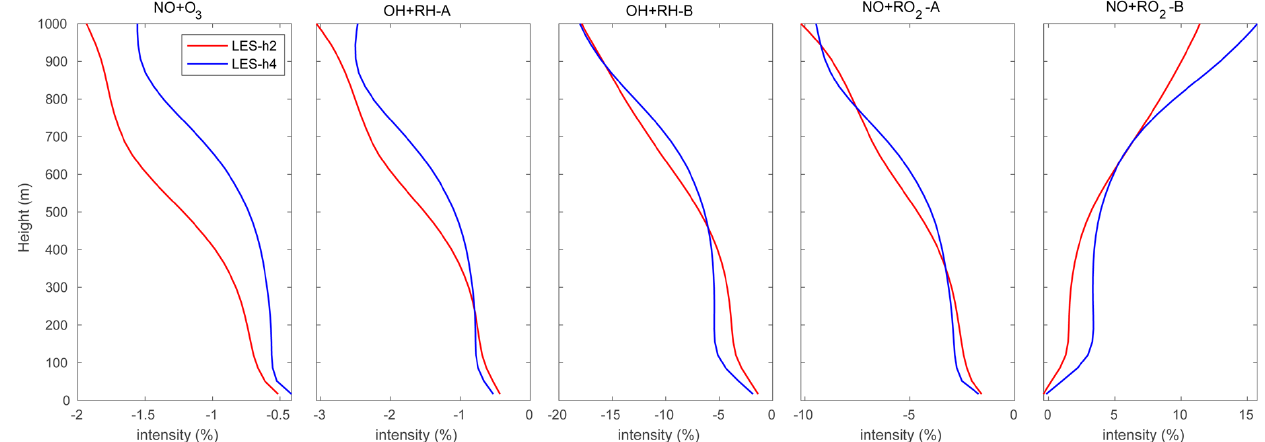
Figure 4. Domain-averaged segregation intensity profiles of selected reactions at hour 2 (red) and hour 4 (blue) for the HOMF